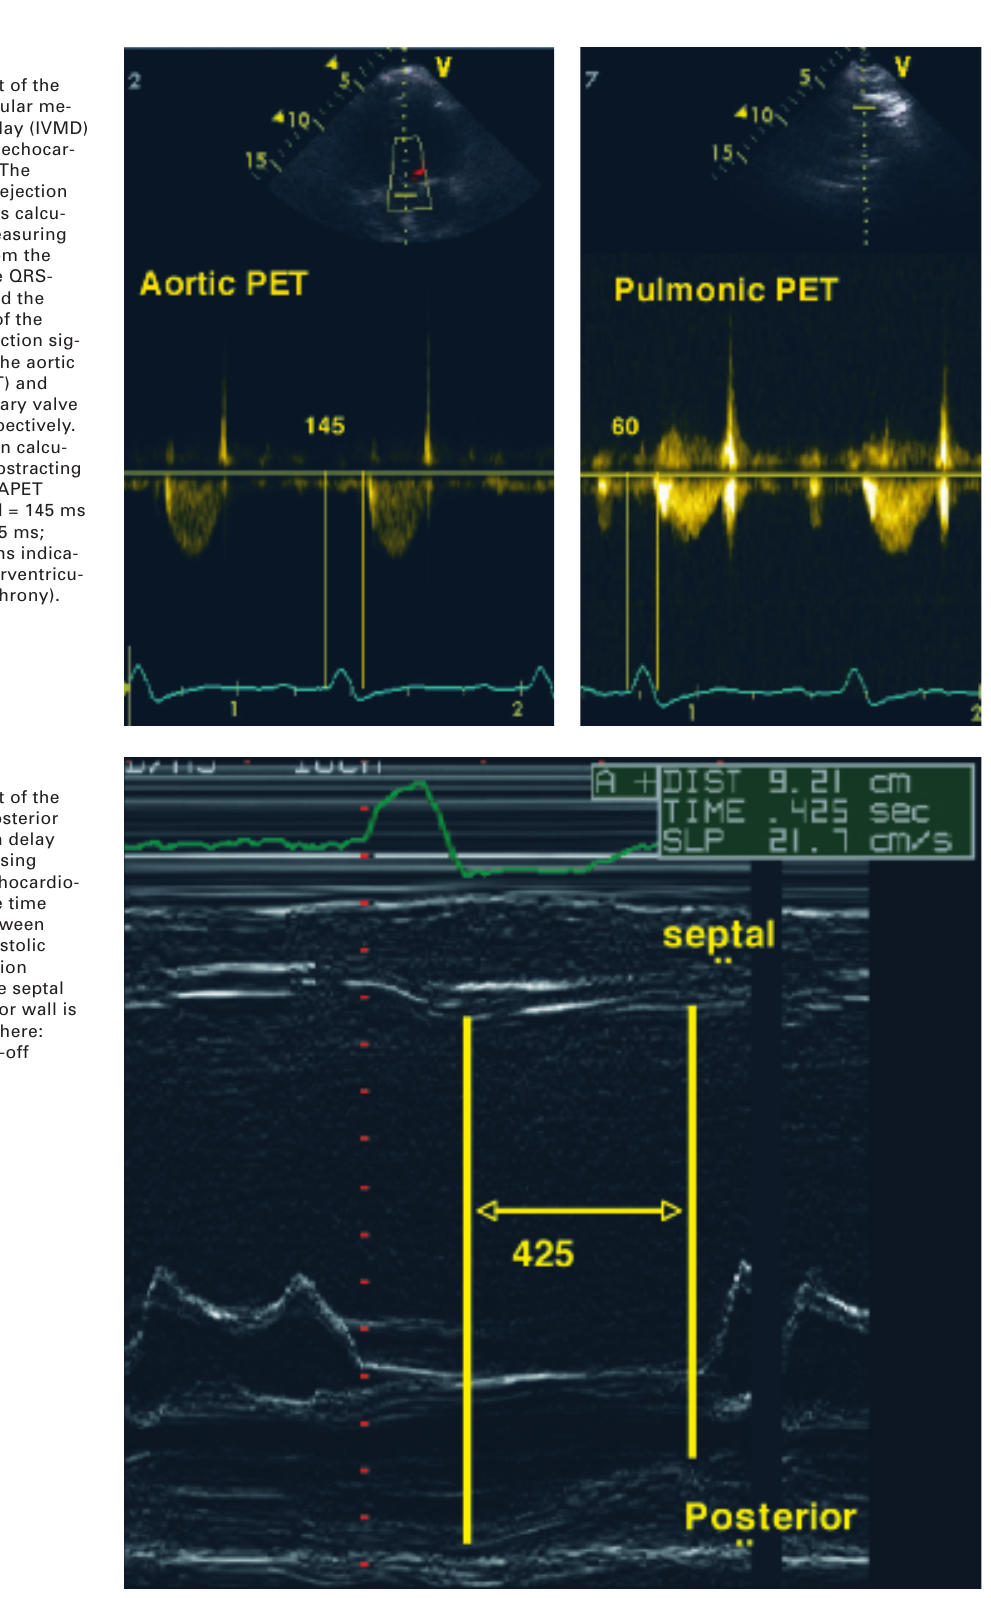
Assessment of the septal to posterior wall motion delay (SPWMD) using M-mode echocardio- graphy. The time interval between maximal systolic inward motion between the septal and posterior wall is calculated (here: 425 ms; cut-off ≥ 130